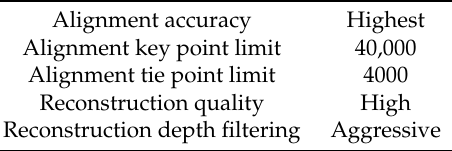
Table 2. Several key model processing parameters used in Agisoft PhotoScan for model